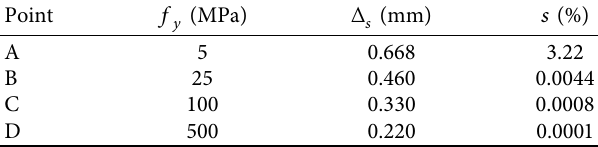
Table 8: Comparison of slip of the frst cycle using FE model.